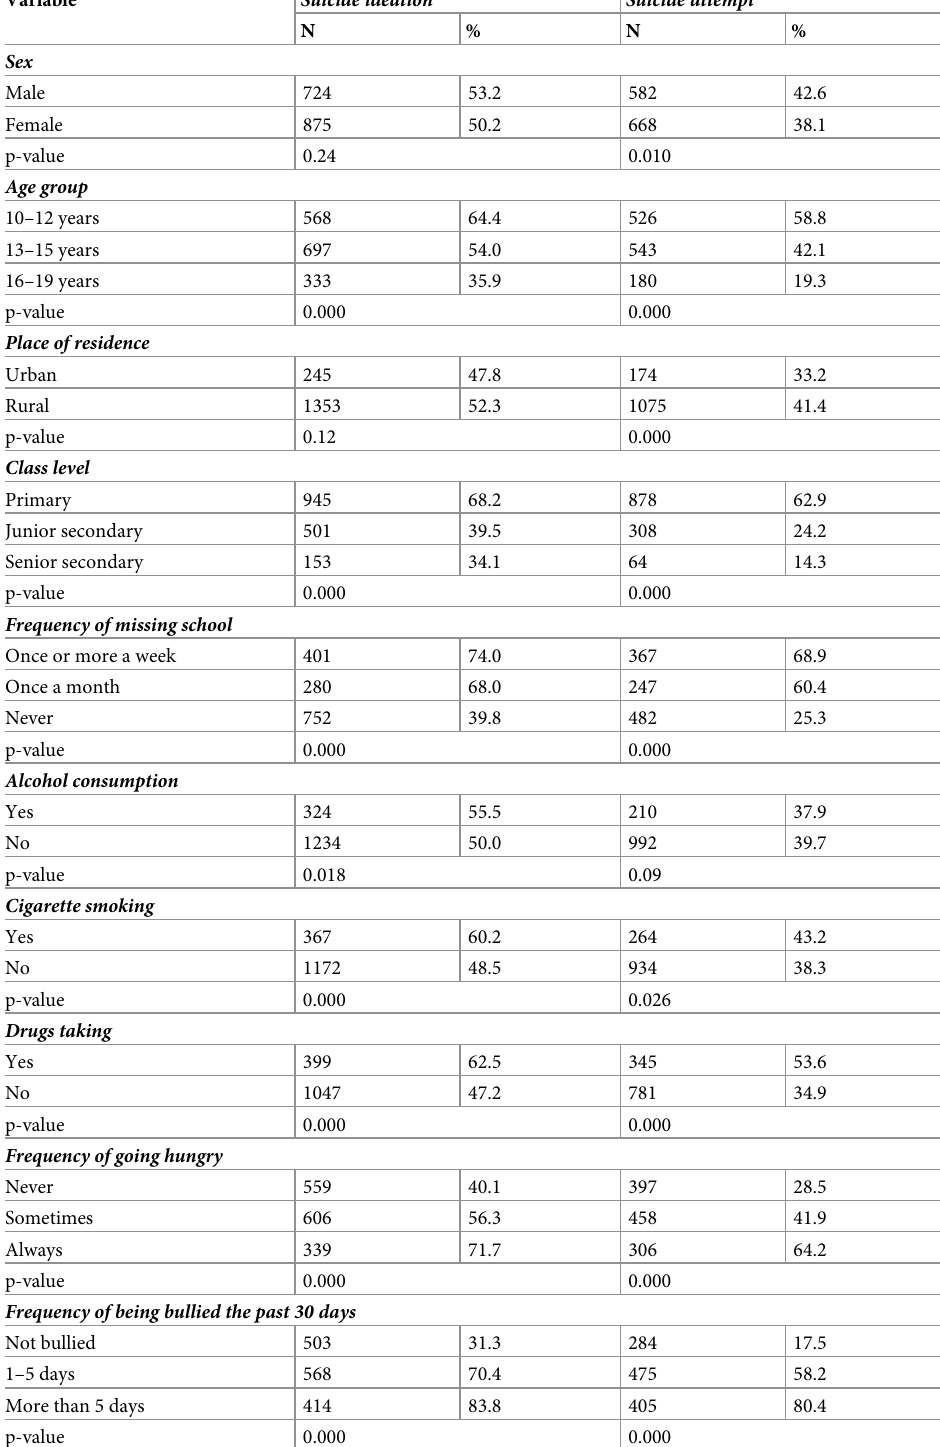
Table 2. Bivariate associations (based on Chi-squared tests) between explanatory variables and each suicidal- behaviour.